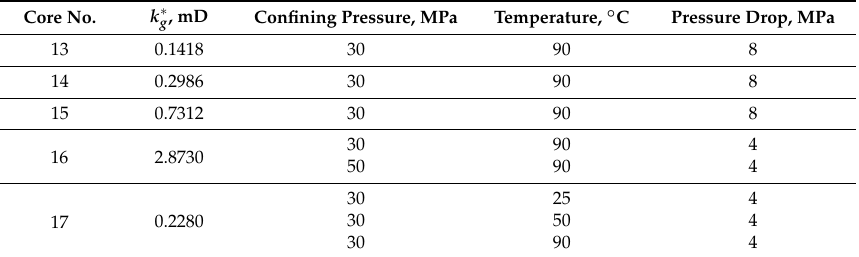
Table 2. Experimental conditions for the sensitivity analysis experiments